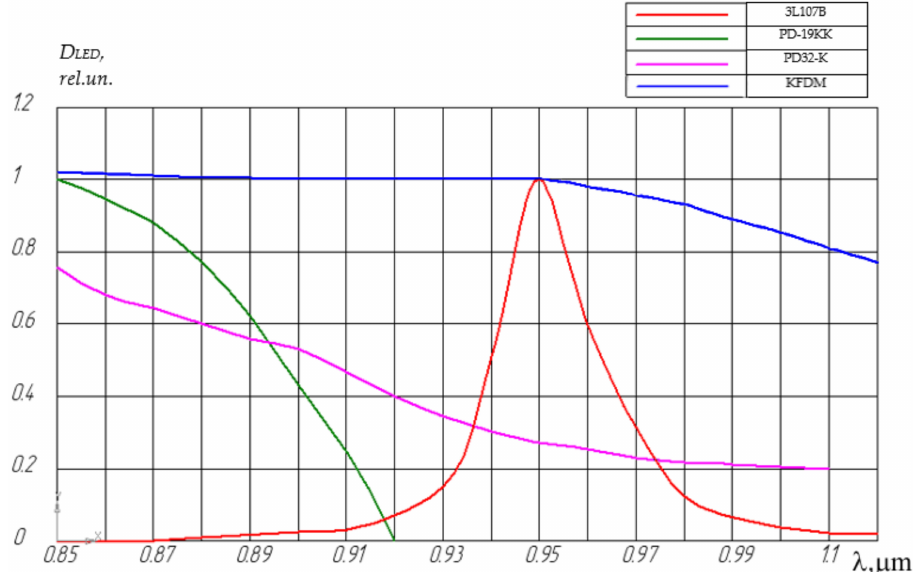
Figure 9. Comparison of LED 3L107B spectral emission and sensitivity of chosen photodiodes.